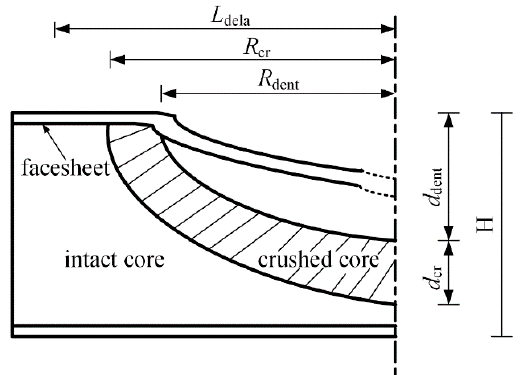
Figure 7. The cross-section schematic diagram throughout the damage region ( L dela, R cr , and R dent represents the length of the delamination, the radii of the crushed core and the indentation, respectively. d dent and d cr indicate the depths of indentation and crushed core, respectively. H stands for the thickness of the sandwich panel).